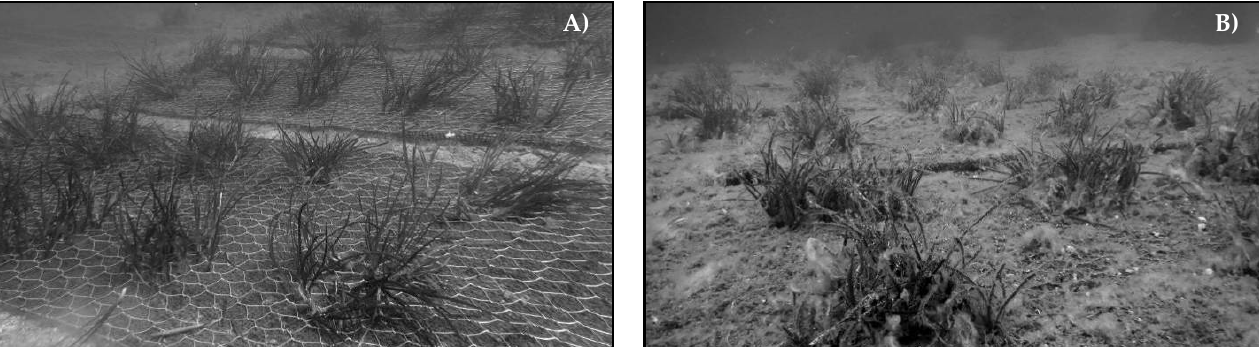
Figure 7. Transplants at Capo Carbonara after the set-up ( A, B ) and after three years ( C, D ).